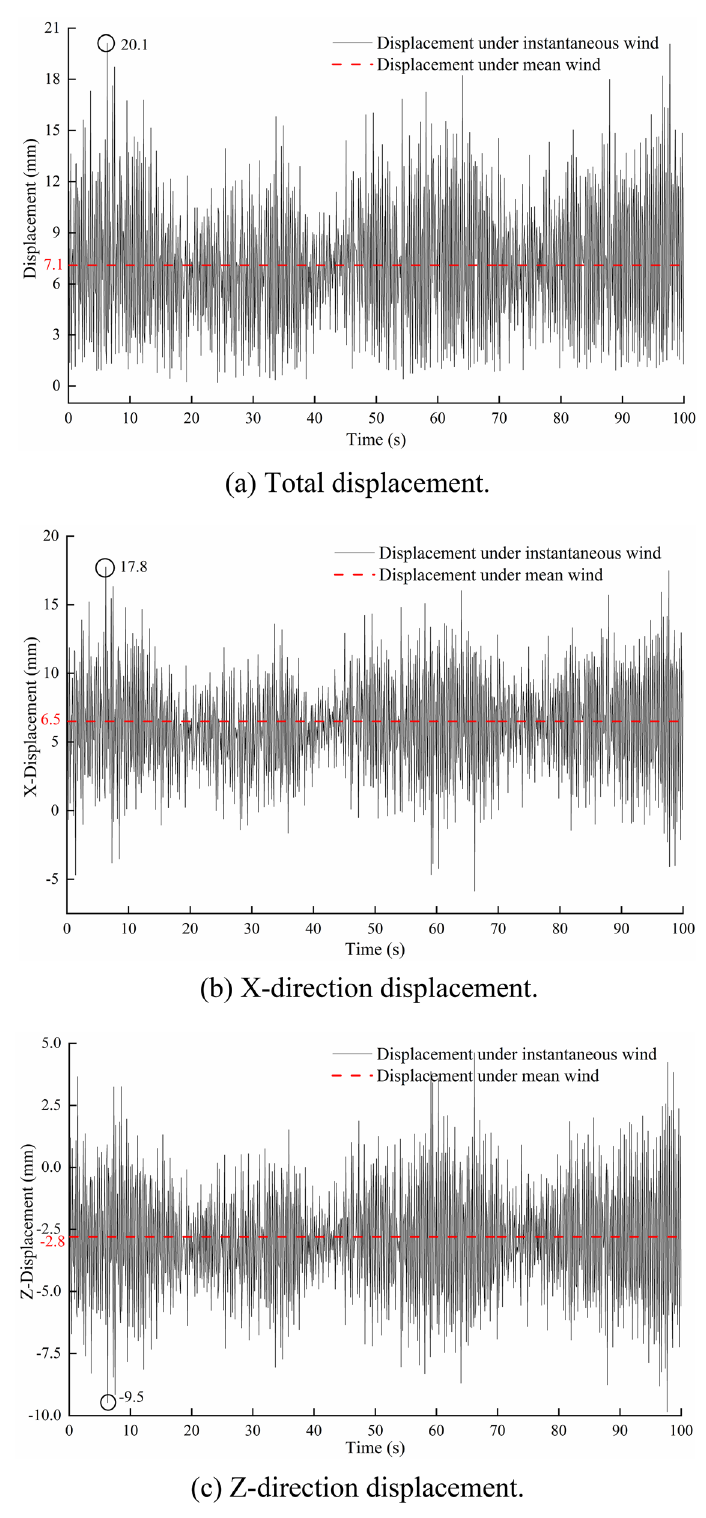
Figure 13. Displacement time history of the maximum displacement